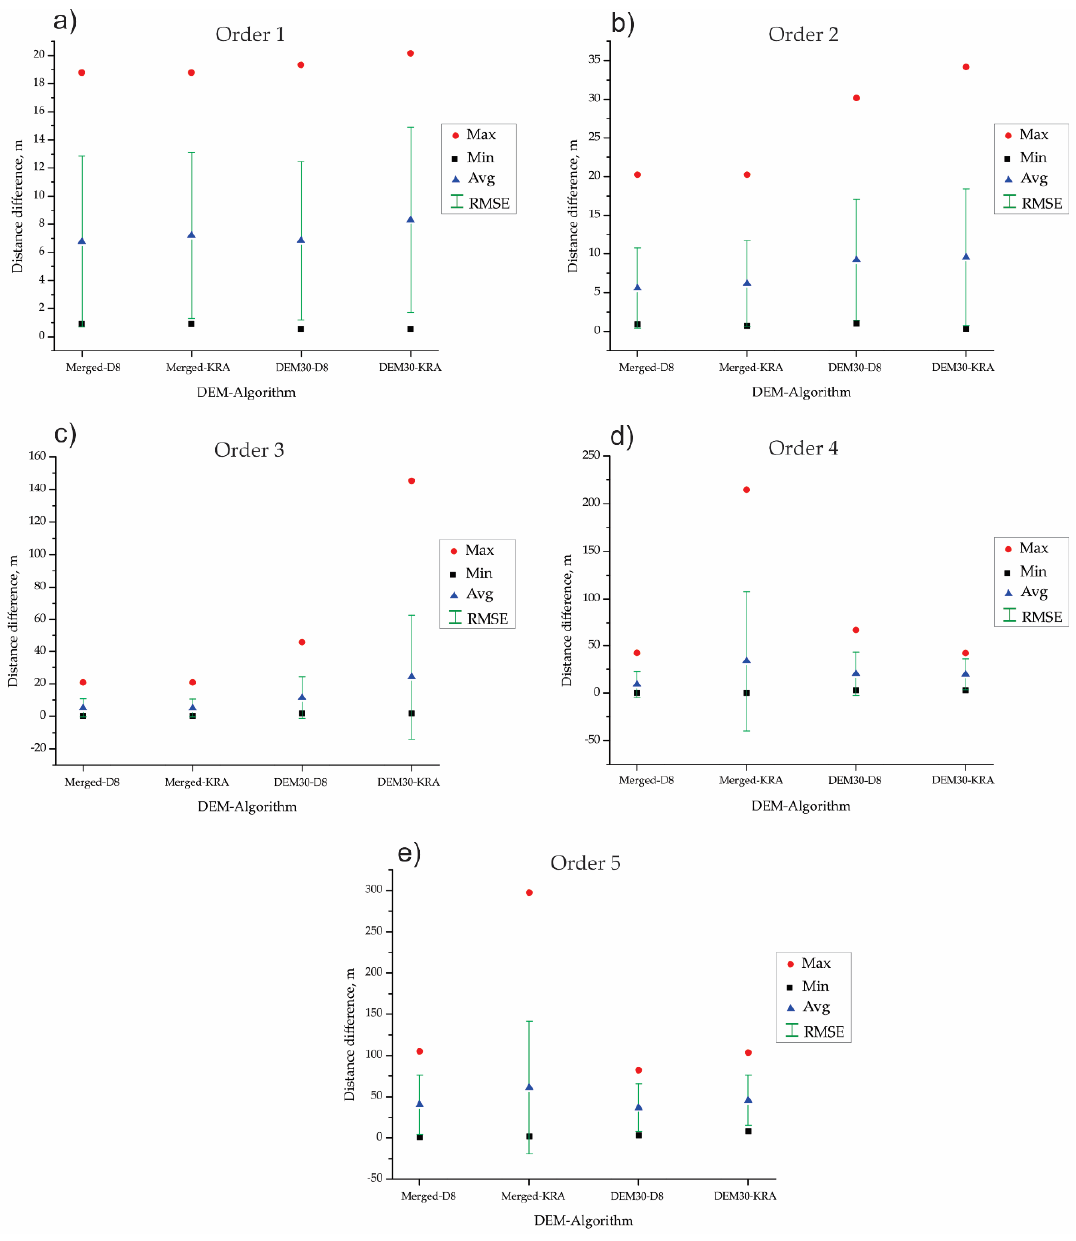
Figure 6. Comparison between the control points and nearest channels of each drainage network: ( a ) distances of stream order 1, ( b ) distances of stream order 2, ( c ) distances of stream order 3, ( d ) distances of stream order 4, and ( e ) distances of stream order 5.